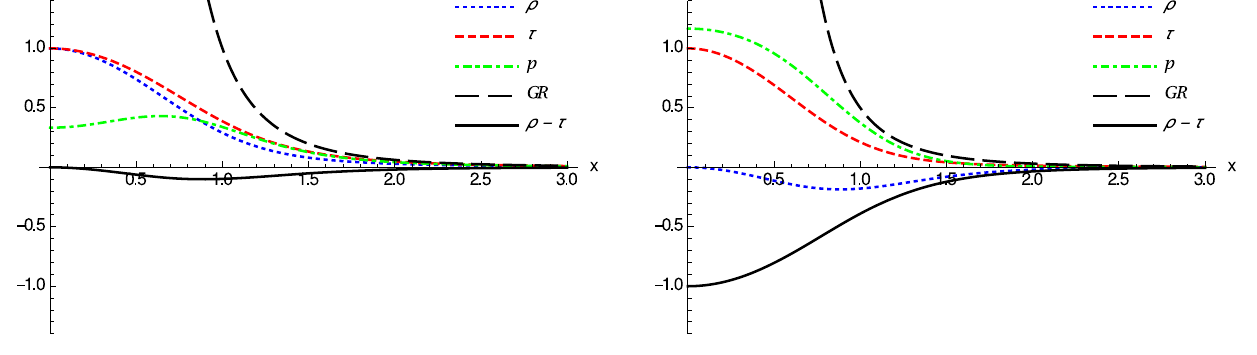
Fig. 3 Same notation and curves as in Fig. 2, for δ 1 = δ c now with N q = N (cid:18) c / 2 (for l (cid:18) = l P ). Here the NEC is violated because ˜ ρ − ˜ τ < 0 (solid black). Note also that though ˜ ρ < 0 near the throat, far away it becomes positive ( ˜ ρ ≈ q 2 / r 4 )